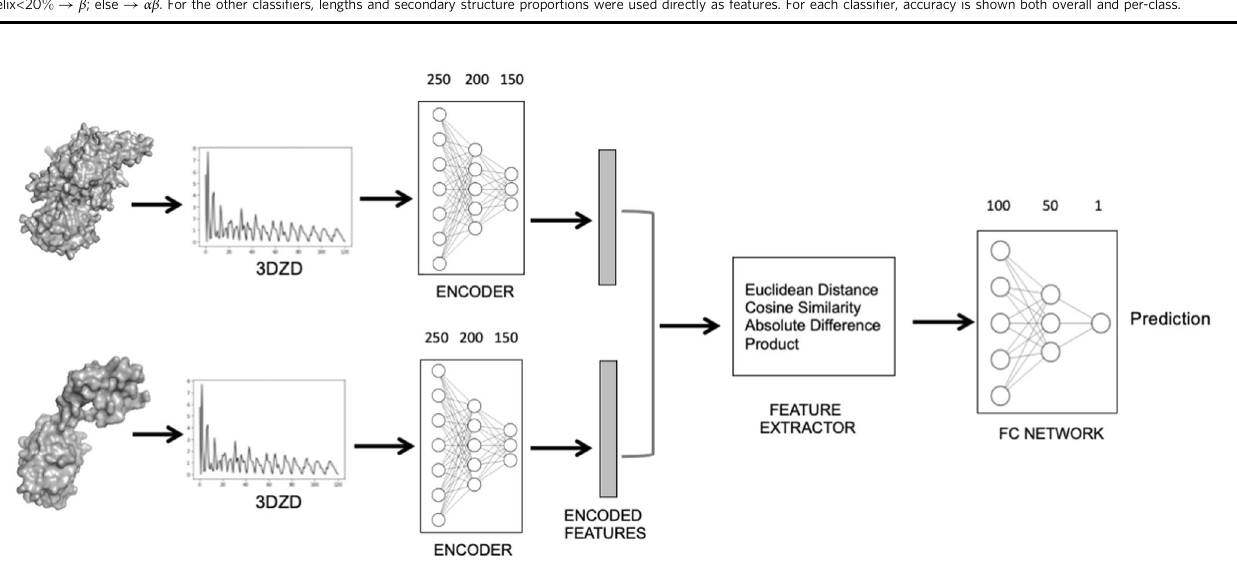
Fig. 3 Deep neural network model for protein fold classi fi cation. The Network takes as input two protein structures represented by their 3DZD vectors. The encoder layer uses the three hidden layers, each with 250, 200, 150 nodes, to encode the features in the 3DZD. The encoding vector of a length of 1452 is then input into the feature extractor layer, which is used to compare the encoded feature of the two structures using four distance metrics, the Euclidian distance, the cosine distance, the Manhattan (absolute value) distance, and dot product. The FC network takes the feature extractor output and predicts the probability that the two structure belong to the same fold. Table 4 Fold classi fi cation accuracy by 3DZD and the deep neural